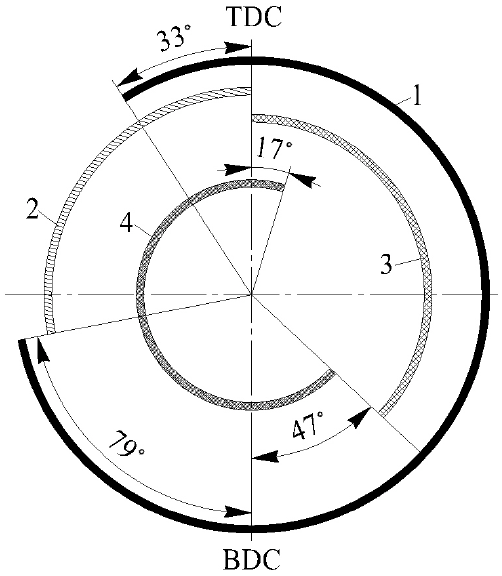
Figure 3. Valve timing for this study: 1—intake process; 2—compression process; 3—expansion process; 4—exhaust process; TDC—top dead centre; BDC—bottom dead centre.